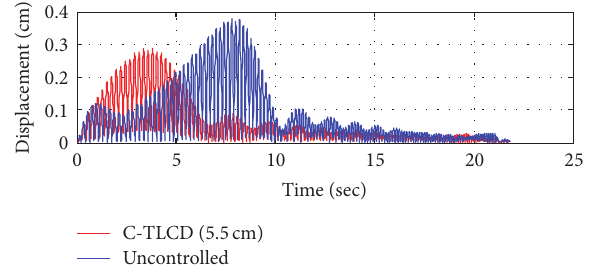
Figure 14: Resultant displacement of the structure in x - and y - direction as a function of time for uncontrolled and controlled structure with C-TLCD ( 𝐻 = 5.5 cm) and 𝛽 = 10 ∘ .